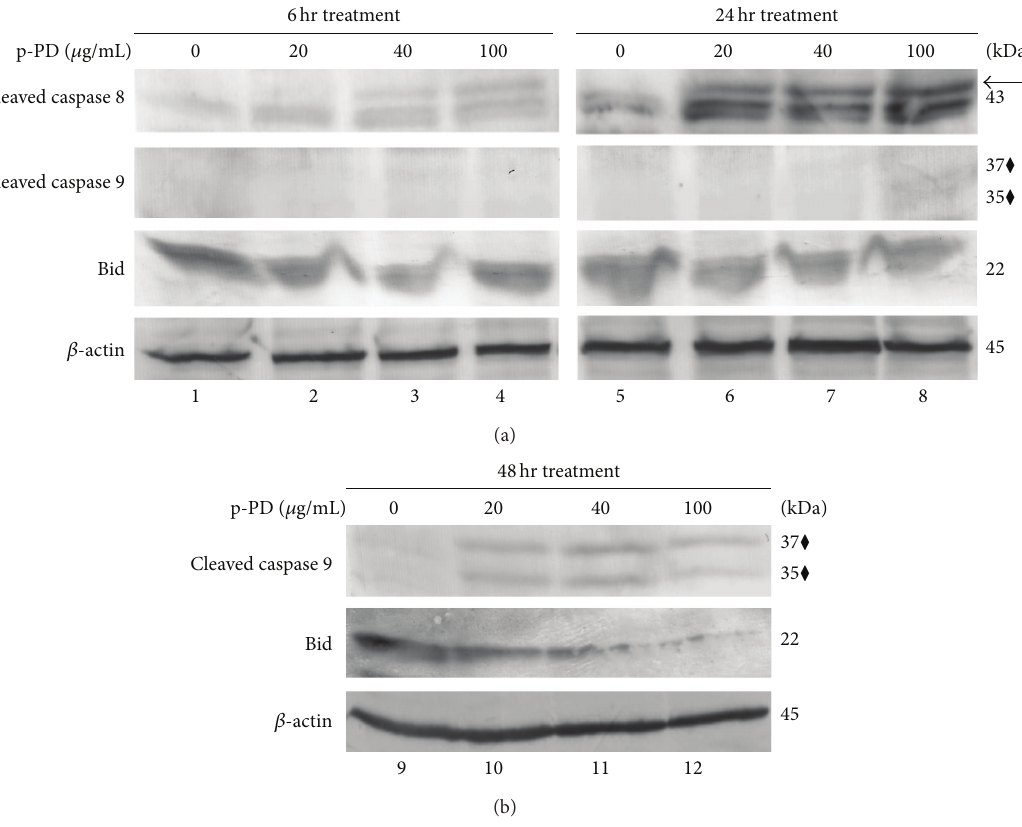
Figure 5: p-PD activates extrinsic apoptotic pathways earlier than the intrinsic ones in human melanoma cells. (a) A375 cells were treated with p-PD as indicated. Cells treated for 6 and 24 hours were lysed with protein loading buffer (Materials and Methods). 30 𝜇 g of total protein lysate (same as described in Figure 3(a)) was loaded in each lane and subjected to western blot and probed for activated caspase 3, activated caspase 8, activated caspase 9, and Bid as indicated. Arrow and “ ⧫ ” indicate the cleaved fragments of caspase 8 and caspase 9, respectively. Cells that were not treated with p-PD (0) but with 0.1% DMSO served as controls. (b) Cells treated for 48 hours were lysed and analysed by western blot as mentioned above by probing with antibodies against active caspase 9 and Bid. “ ⧫ ” indicates both cleaved fragments of caspase 9. 𝛽 -actin is used as a loading control for both panels. These blots are representative of three independent